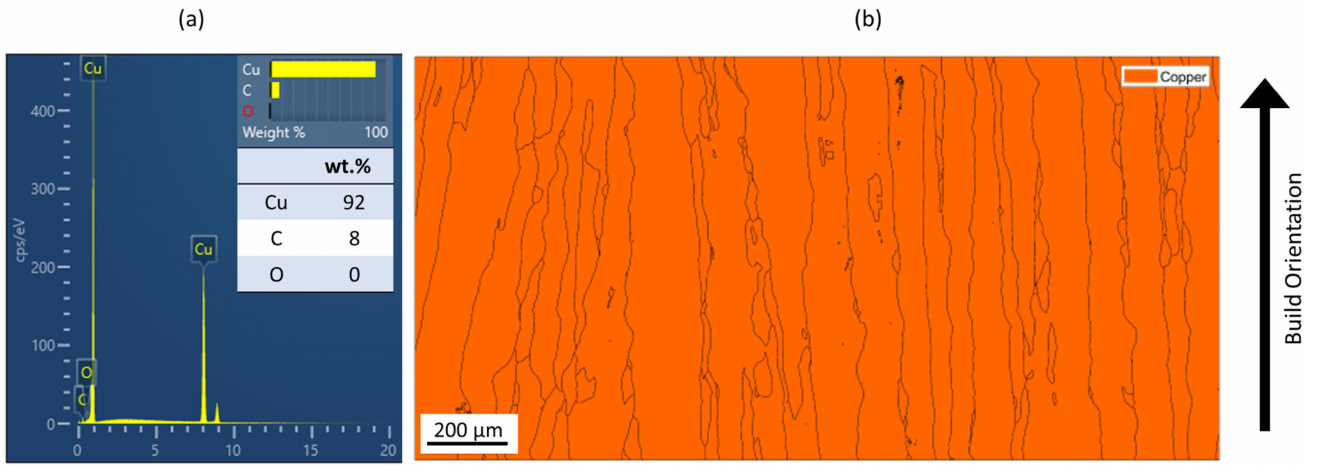
Figure 3. ( a ) EDX spectrum of Cu Sample manufactured with 8.64 J/mm 2 ; ( b ) EBSD Phase Analysis of Cu sample with E A 8.64 J/mm 2 .